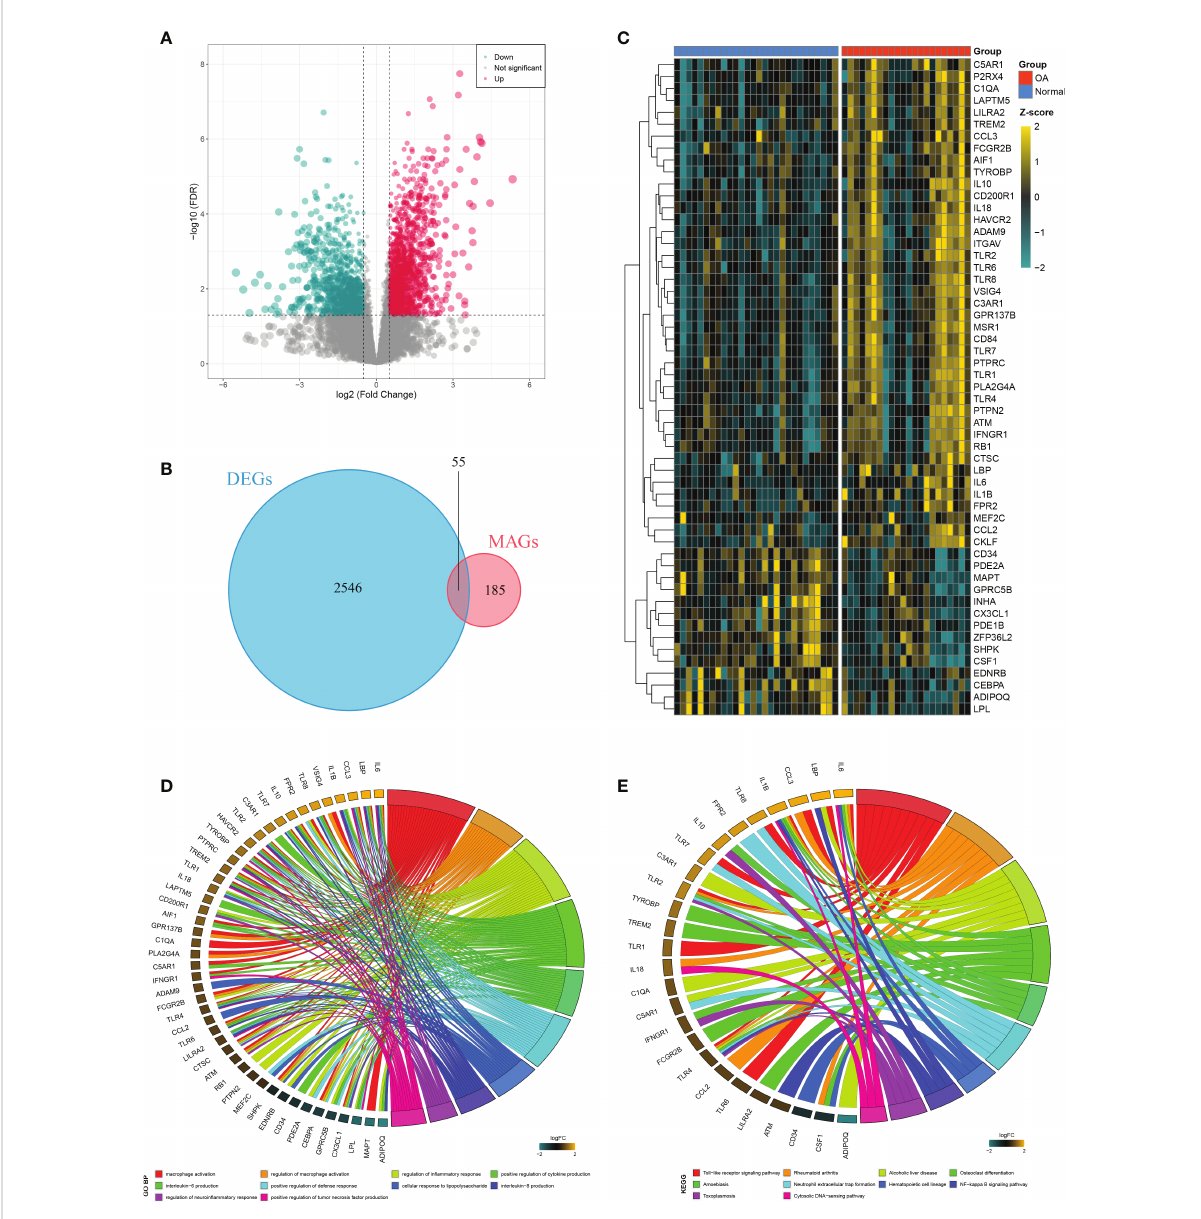
FIGURE 3 Identi fi cation of DEMAGs and functional annotation. (A) Volcano plot of DEGs between OAs and controls. (B) Venn diagram showed the intersection of MAGs and DEGs. (C) Heatmap of the expression of the DEMAGs. D-E. GO (D) and KEGG (E) enrichment analyses of